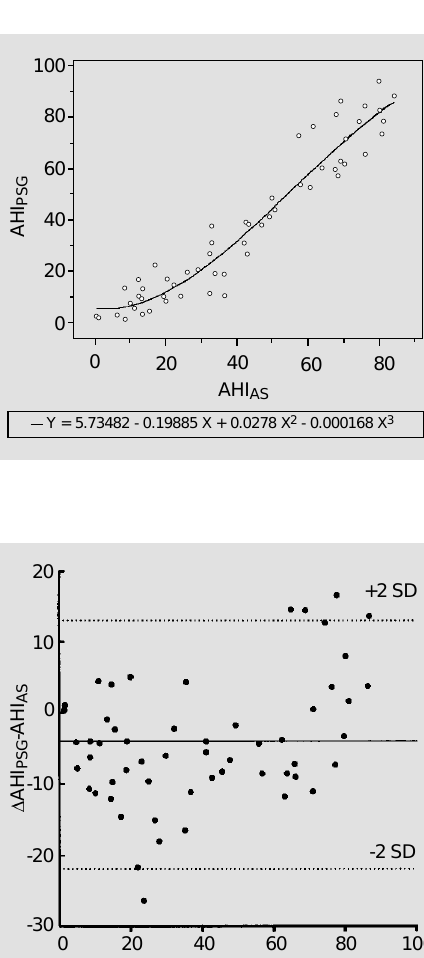
Figure 1 - Regression analysis of the relationship of AHI PSG val- ues to those obtained by AHI AS . AHI: Apnea-hypopnea index; PSG: polysomnography; AS: AutoSet™.